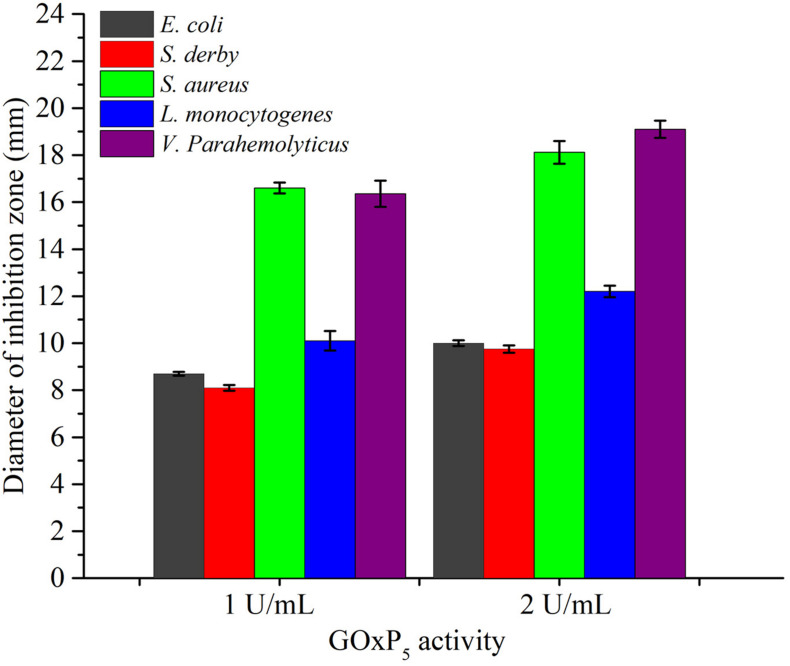
The average diameter of inhibition zones of GOxP5 against five bacterial strains (E. coli, S. derby, S. aureus, V. parahemolyticus, L. monocytogenes).